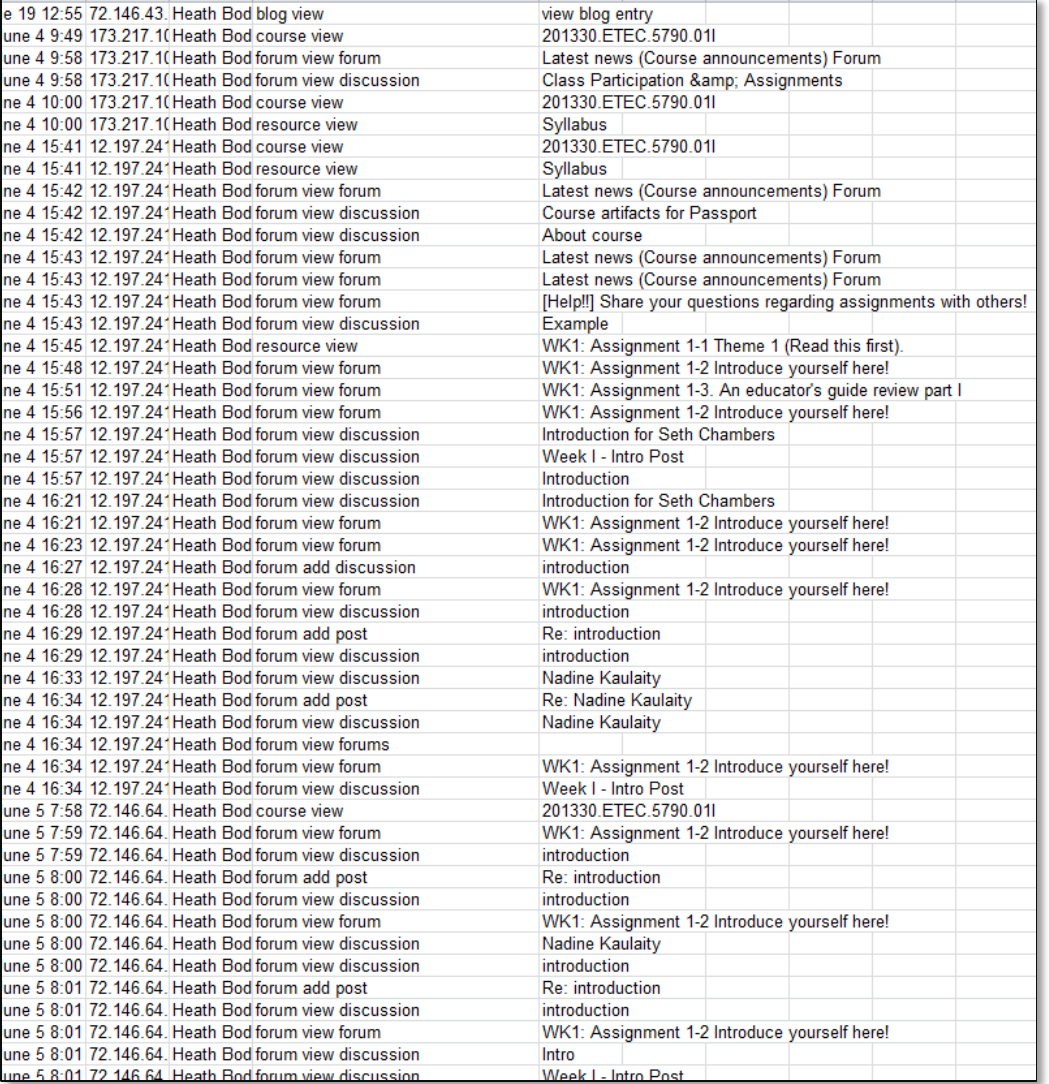
Figure 2. Example of Web log data